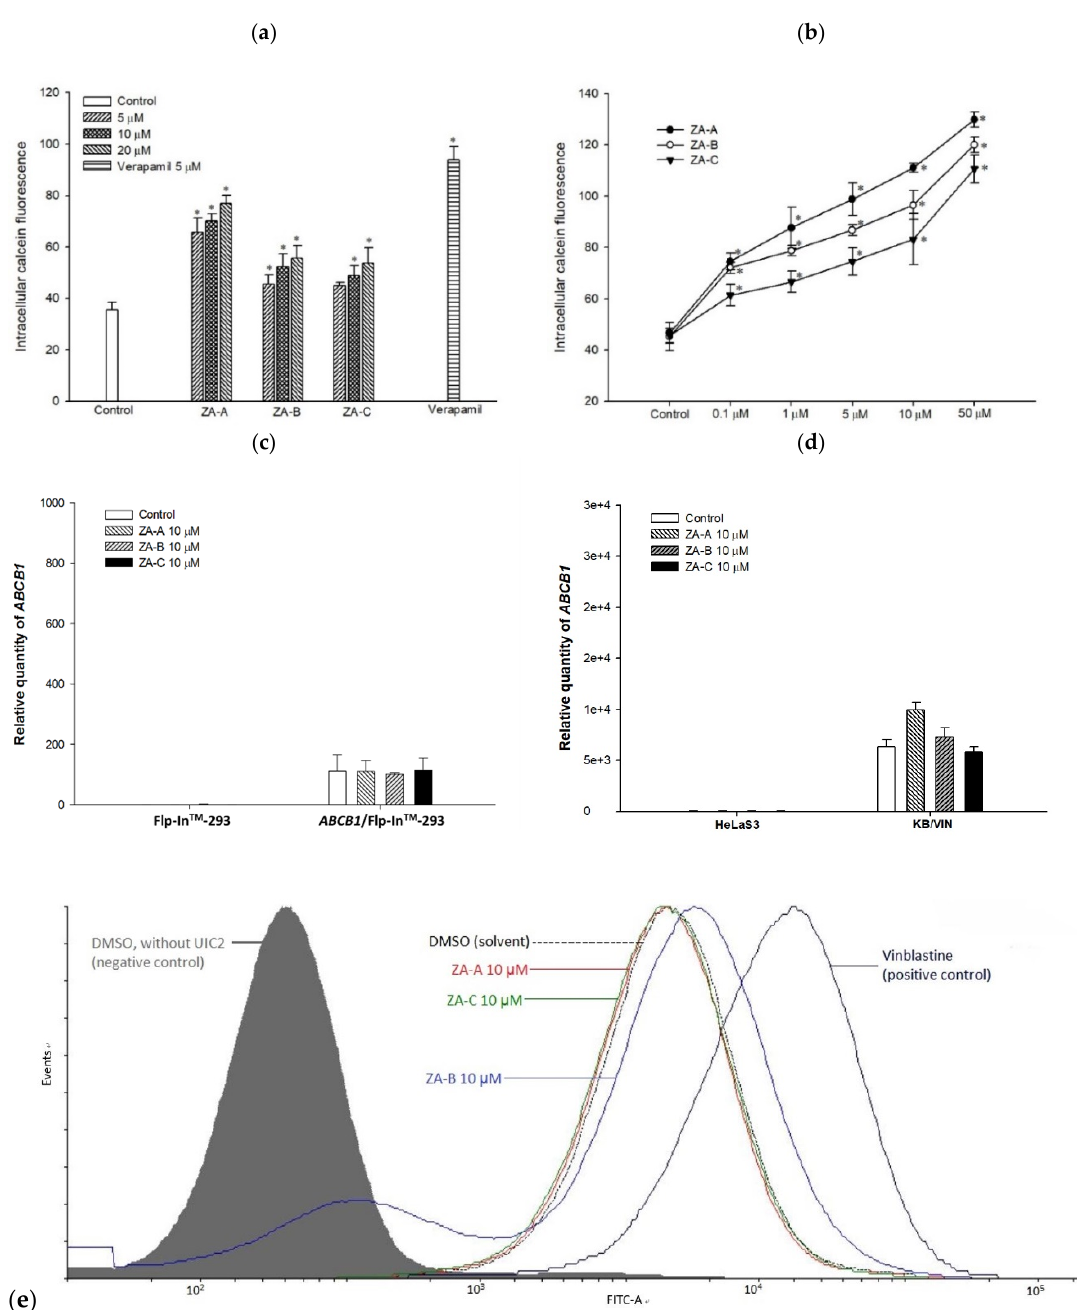
Figure 1. The effects of Zhankuic acids A, B and C (ZA-A, ZA-B and ZA-C) on human P-glycoprotein (P-gp). ( a ) Intracellular calcein fluorescence with or without ZA-A, ZA-B or ZA-C pretreatment in ABCB1/Flp-In TM -293 cell line (over-expressing human P-gp). Verapamil 5 μM was used as a positive control. * denotes p < 0.05 compared with the intracellular calcein fluorescence in control group. ( b ) The dose-dependent effects of ZA-A, ZA-B or ZA-C on calcein retention in ABCB1/Flp-In TM -293. * denotes p < 0.05 compared with the intracellular calcein fluorescence in control group. ( c ), ( d ) There were no significant ABCB1 mRNA expression differences after treating the ABCB1/Flp-In TM -293 or KB/VIN with 10 μM ZA-A, ZA-B or ZA-C for 72 h. © The conformation of P-gp was not influenced under the treatment of 10 μM ZA-A, ZA-B or ZA-C. Vinblastine was used as a positive control.